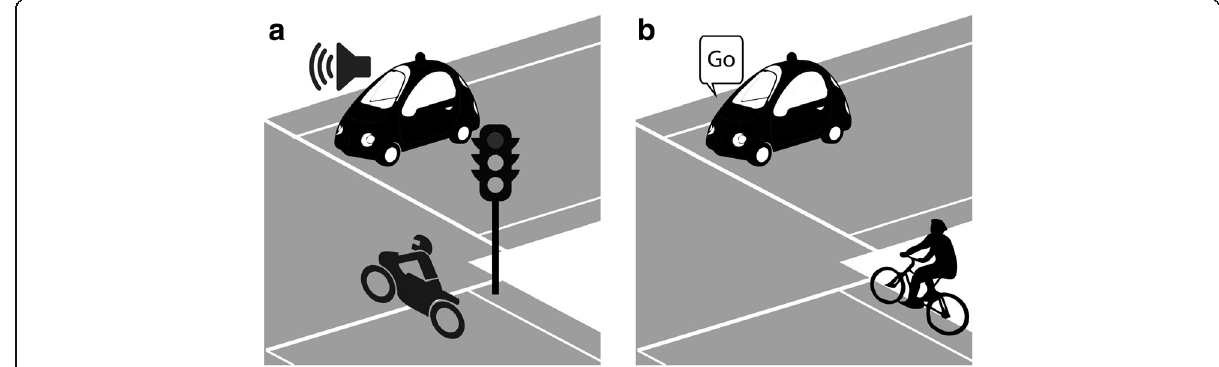
Fig. 2 Possibilities for giving real-time feedback if an automated vehicle detects a a hazard or b an